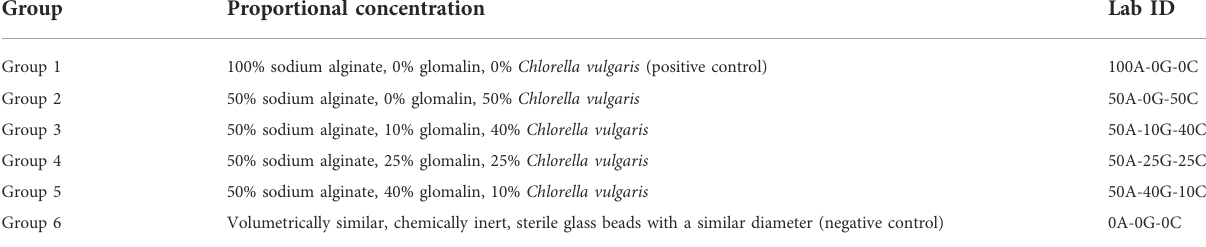
TABLE 1 Six treatment groups with proportional concentration of sodium alginate, glomalin, and Chlorella vulgaris . Group Proportional